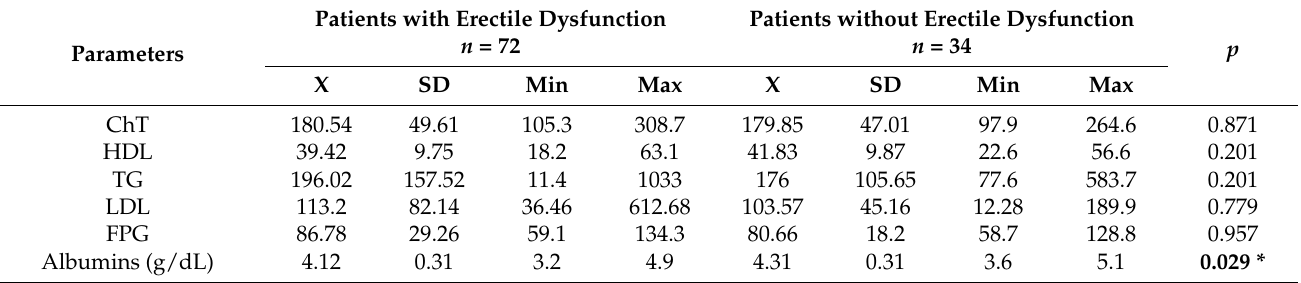
Table 3. Analysis of the relationship between biochemical parameters in men depending on the score in the International Index of Erectile Function.